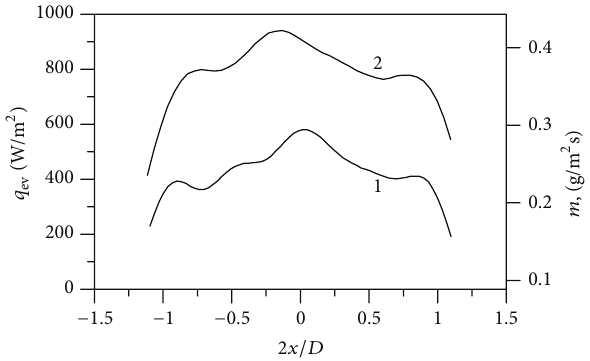
Figure 5: Calculated distribution of evaporation heat flux density and evaporation rate: (1) drop from Figure 3(a) and (2) drop from Figure